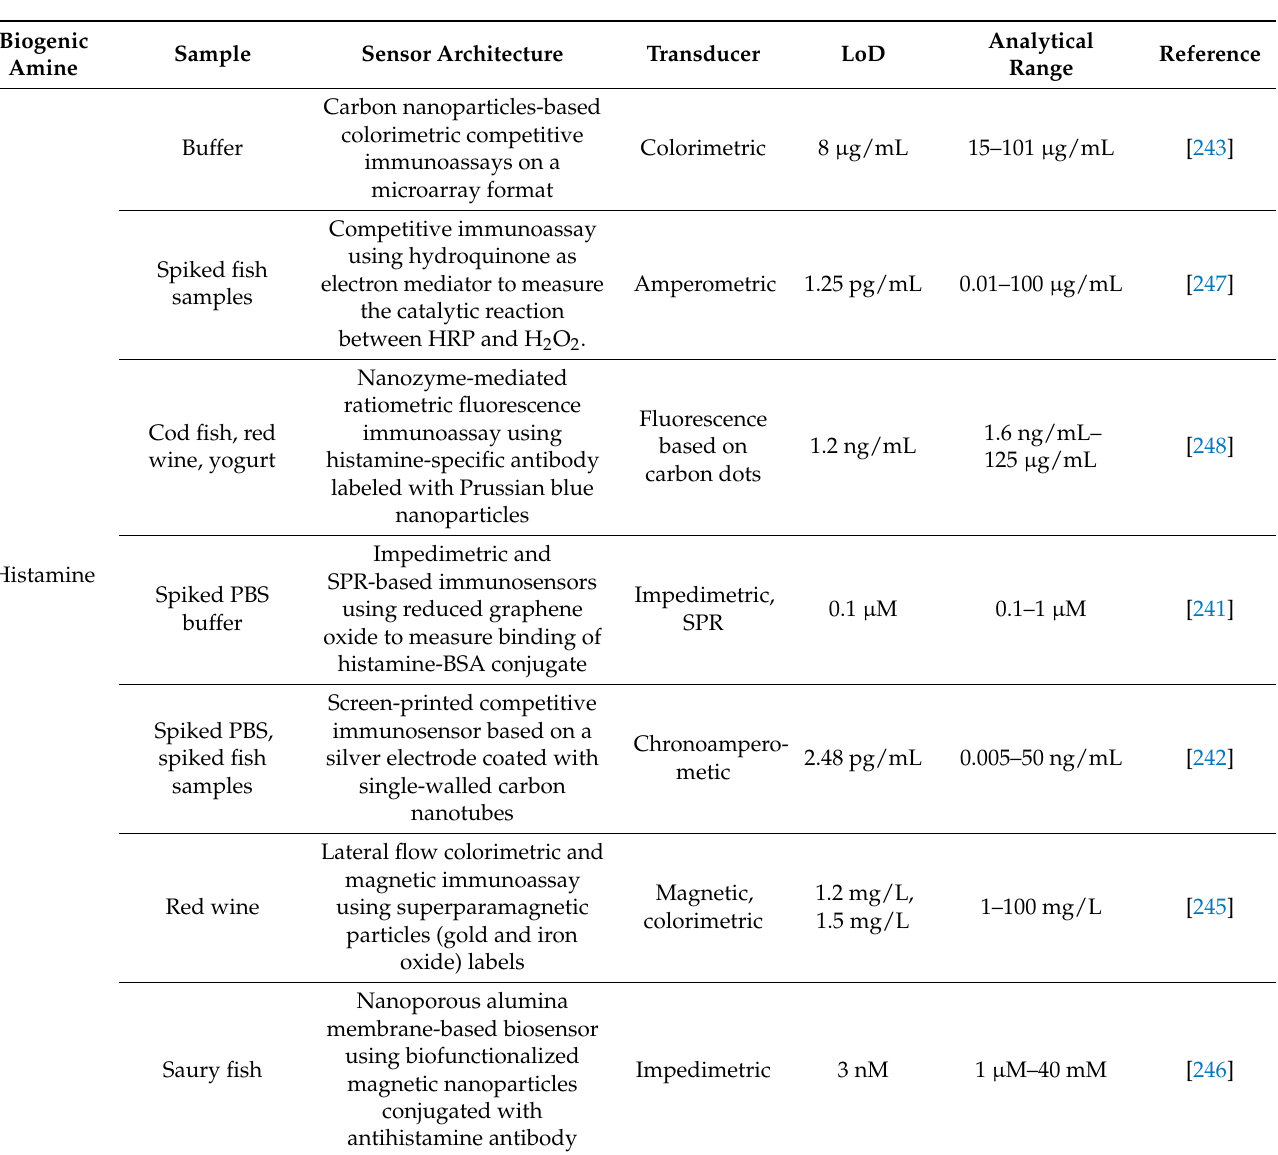
Table 4. Overview of selected immunosensors for histamine detection based on mono- and polyclonal antibodies together with a brief description of the assay and sensor architecture. To best of our knowledge, there are no publications on immunosensors for BAs other than